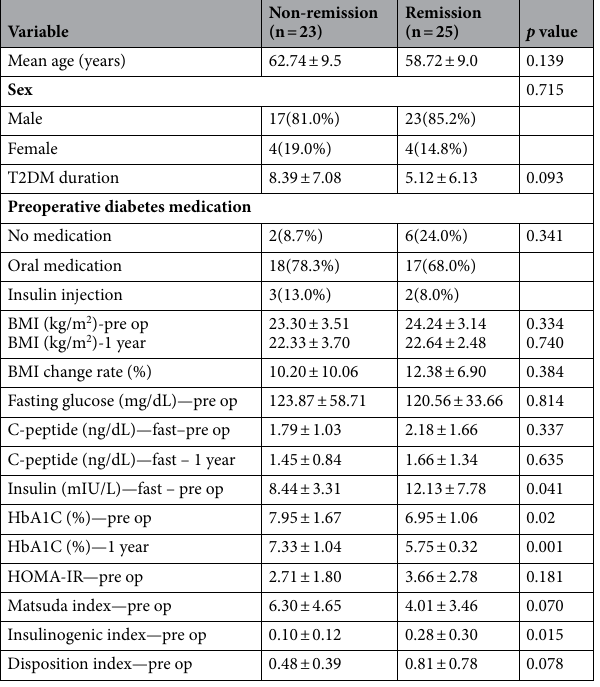
Table 1. Clinical characteristics of patients included in this study (non-remission vs remission). T2DM Type 2 Diabetes Mellitus, BMI Body mass index, HOMA-IR Homeostatic model assessment of insulin resistance.